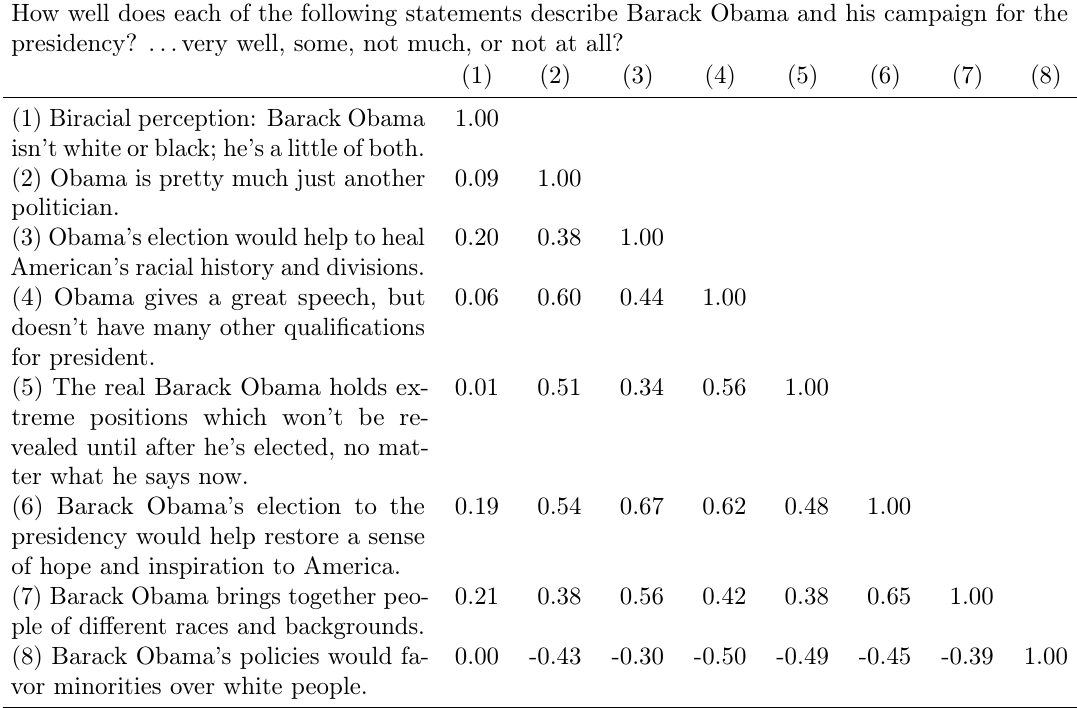
Table 1: Pairwise Correlation Coefficients Between Biracial Perception and Other Measures of Barack Obama and His Presidential